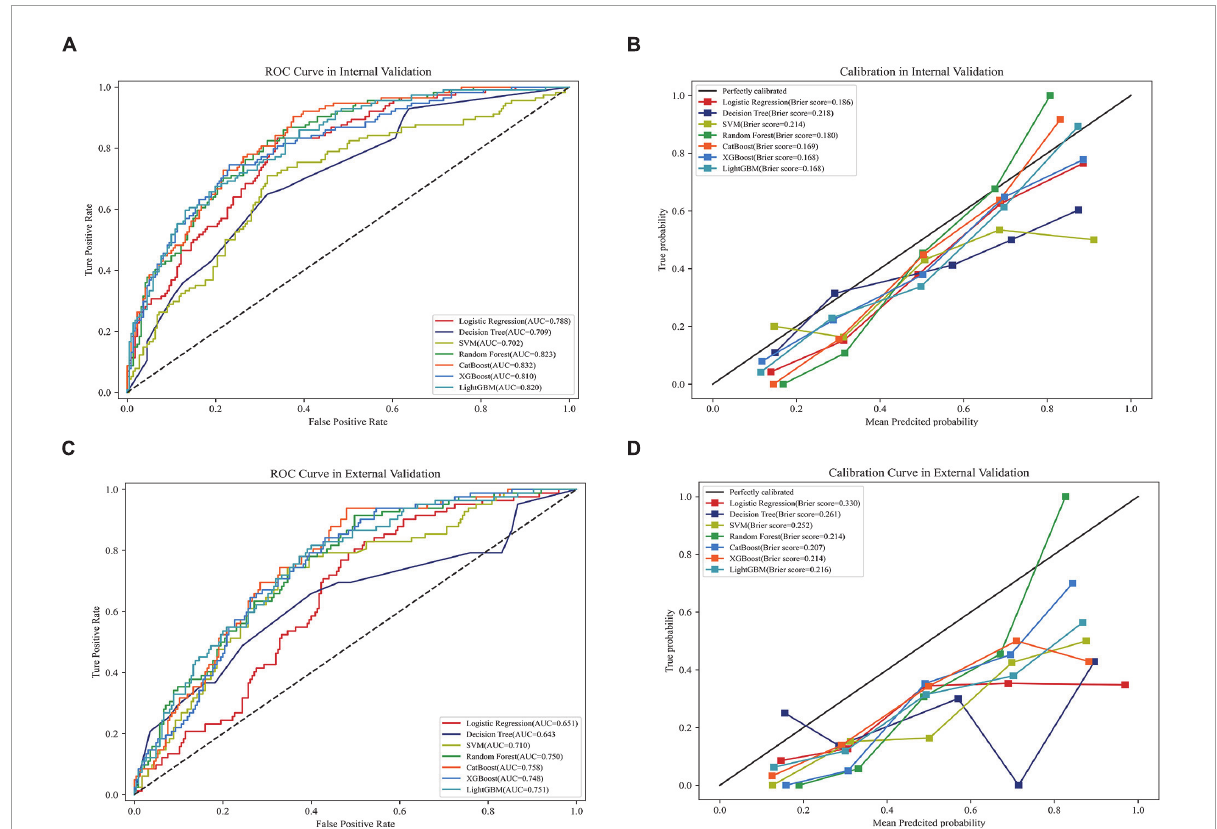
FIGURE3 Performance of the models in internal and external validation. (A) ROC curves of the seven models in internal validation; (B) calibration curves of the seven models in internal validation; (C) ROC curves of the seven models in external validation; (D) calibration curves of the seven models in external validation. ROC, receiver operating characteristic curve; AUC, area under the curve; SVM, support vector machine; XGBoost, eXtreme gradient boosting; CatBoost, categorical boosting; LightGBM, light gradient boosting